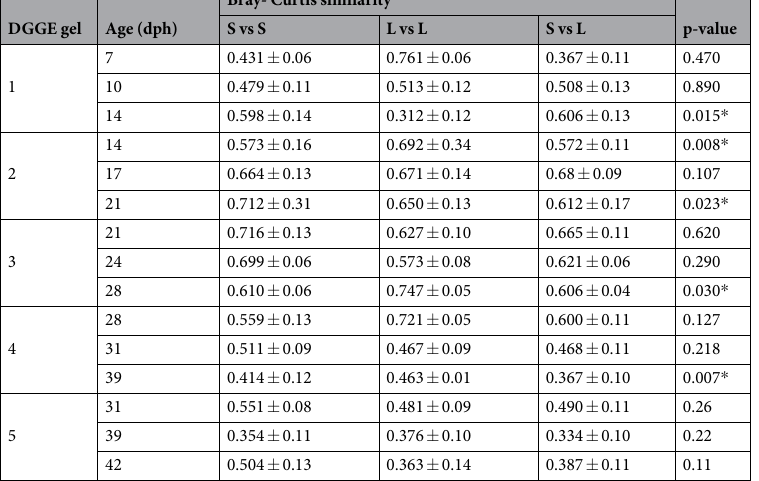
community composition are visualized by NMDS ordination (Fig. 2). The differences in bacterial community composition are indicated by 1) strong clustering of large and small larvae but limited separation of the two clus- ters (e.g. 14 dph, Fig. 2A), 2) less clustering within S and L larvae but a clear separation between them (39 dph, Fig. 2D), or 3) a combination of both. One-Way PERMANOVA confirmed significant difference in the bacterial community profiles between small and large individuals at 14, 21, 28 and 39 dph, but not for the other six sampling days (Table 2). Surprisingly, significant differences were normally detected both when between-groups-similarity was high (14, 21 and 28 dph), and when it was low (39 dph). In some cases where the samples have been included on two DGGE gels, the statistical tests are diverging. However, variation in exact denaturing gradients and variable quality among DGGE gels will affect the community profiles, and consequently we put more emphasis on gels with higher resolution. Correlations between age and microbial community composition. The highest band richness was observed after onset of first feeding (7 dph) and the band richness varied between 17 and 21 among individuals (Table 3). A general trend of reduced diversity indices was observed up to 28 dph (Table 3). For older larvae, the indices describing diversity of the microbiota increased again. Thus, the diversity of the larval microbiota seemed to be highest at both early and late larval stages. Bray-Curtis similarities were low for comparisons of the larval microbiota community composition between age groups (each group included both small and large larvae; Fig. 3). One-way PERMANOVA analysis revealed significant differences in the community composition of the microbiota between all the 10 age groups (p < 0.0075 and mean p = 0.001, Table S2). Despite significant differences in the microbiota of cod larvae between all age groups, at 14, 17, 21, 24 and 28 dph two particular DGGE band were strong in the DGGE profiles of almost all individuals (Fig. S1). Both these bands were found to represent the genus Arcobacter (Epsilon-proteobacteria).